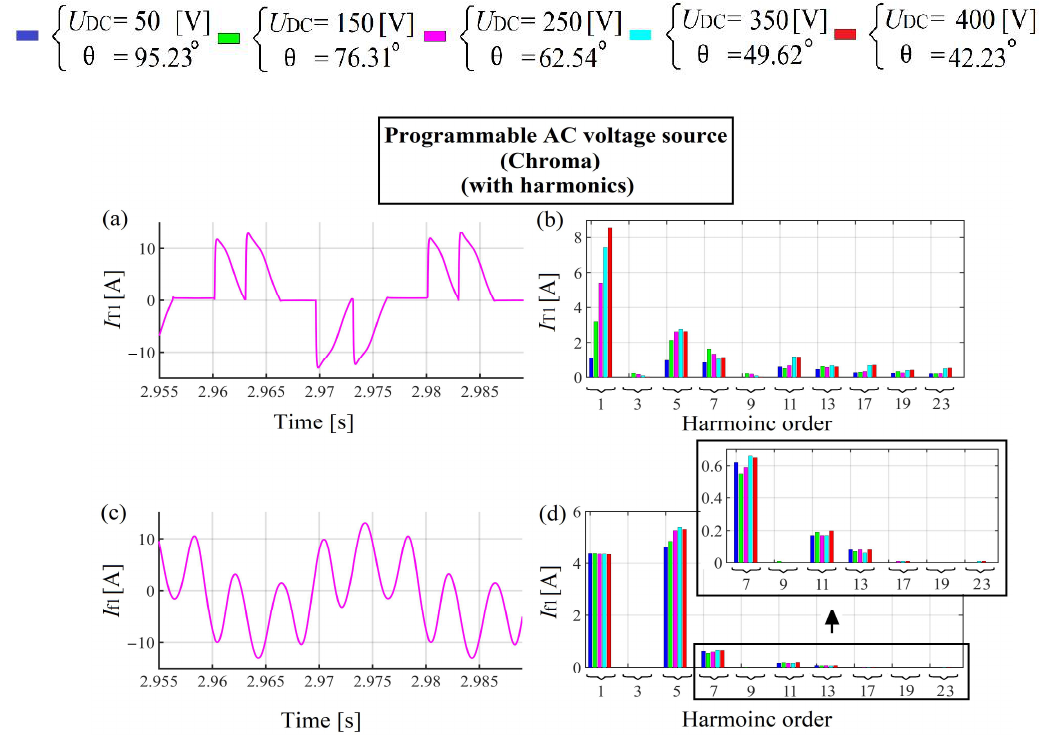
Figure 27. ( a ) Rectifier input current waveform with ( b ) its spectrum, ( c ) filter current waveform with ( d ) its spectrum.